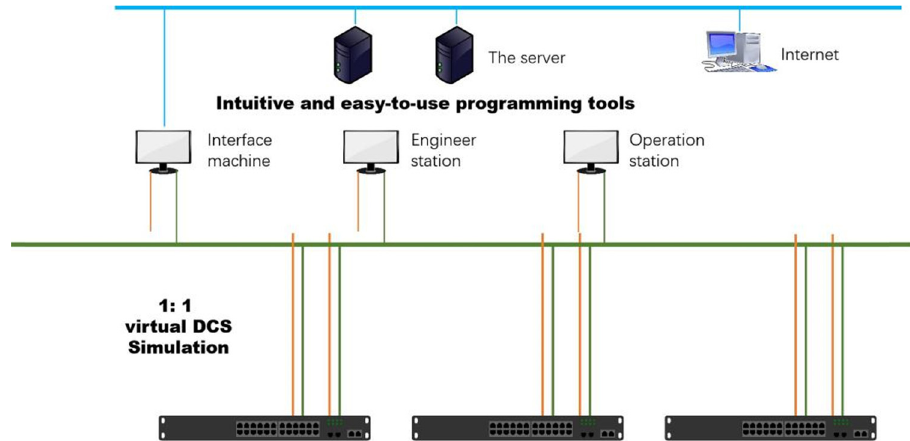
Figure 1: Industrial process control